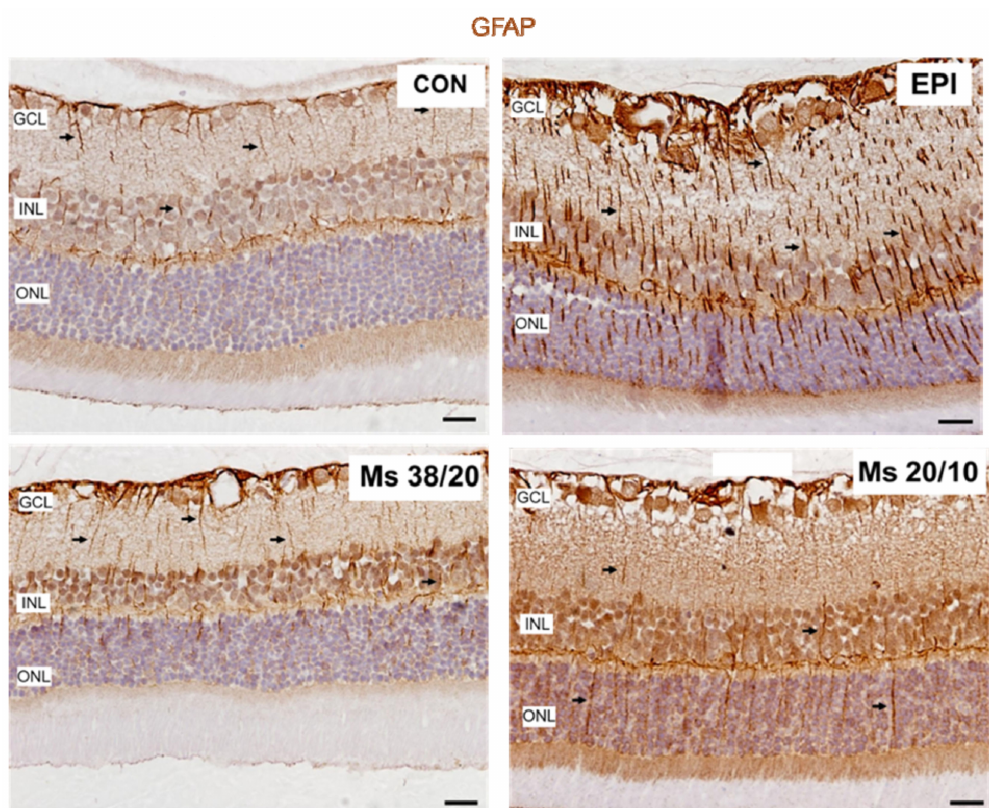
Figure 8. Overexpression of GFAP (gliosis) was observed in retinas of all ocular hypertensive (OHT) right eyes at 8 weeks. Note the expression of GFAP in the cytoplasmatic prolongations of Müller cells (arrows). The retinas of contralateral (left) eyes also showed gliosis, although the expression of GFAP by Müller cells was lower. Abbreviations: CON: repre- sentative retinal section from a contralateral (left) eye; EPI: representative retinal section from a right eye injected in the episcleral vein; Ms38/20: representative retinal section from a right eye injected with 38–20 µ m microspheres; Ms20/10: representative retinal section from a right eye injected with 20–10 µ m microspheres; GCL: ganglion cell layer; INL: inner nuclear layer; ONL: outer nuclear